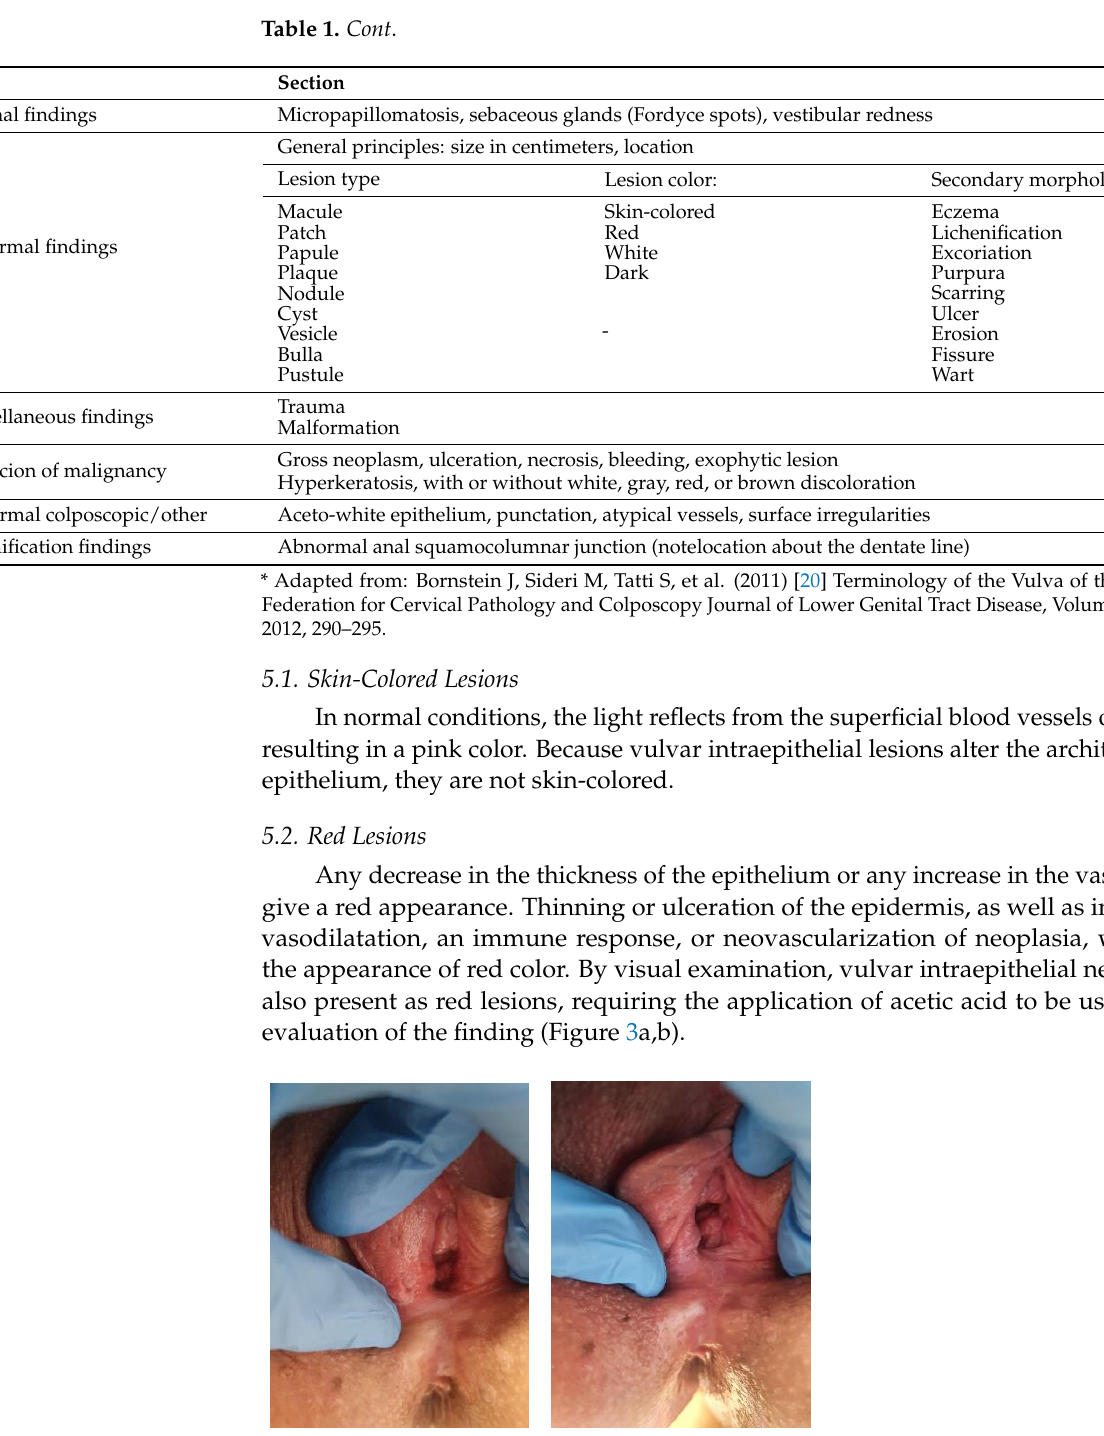
Figure 4. Folliculitis. Figure 5. Lichen planus.